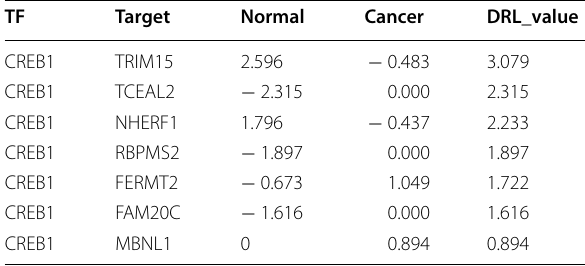
Table 4 The regulation efficacy of CREB1 on its targets